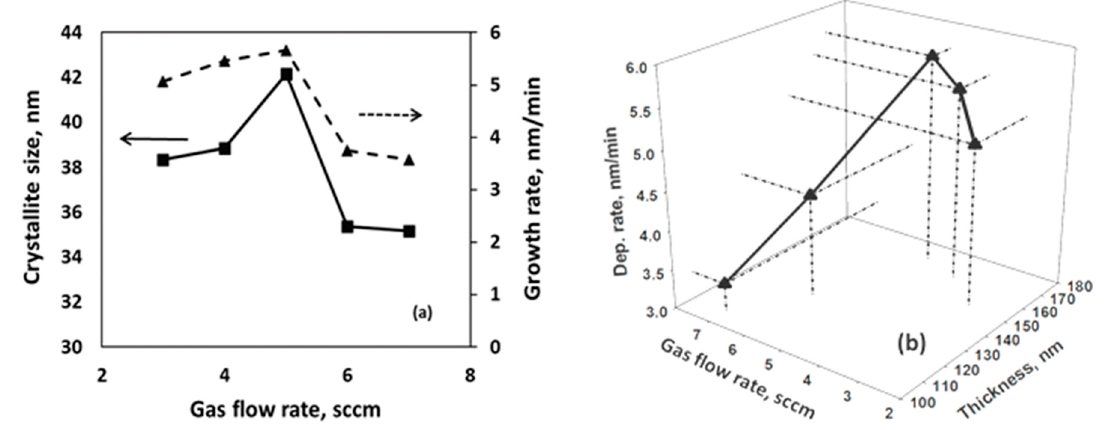
Figure 3. ( a ) Crystallite size and growth rate and ( b ) thickness and deposition rates of as-grown WS 2 under different Ar gas flow rates.